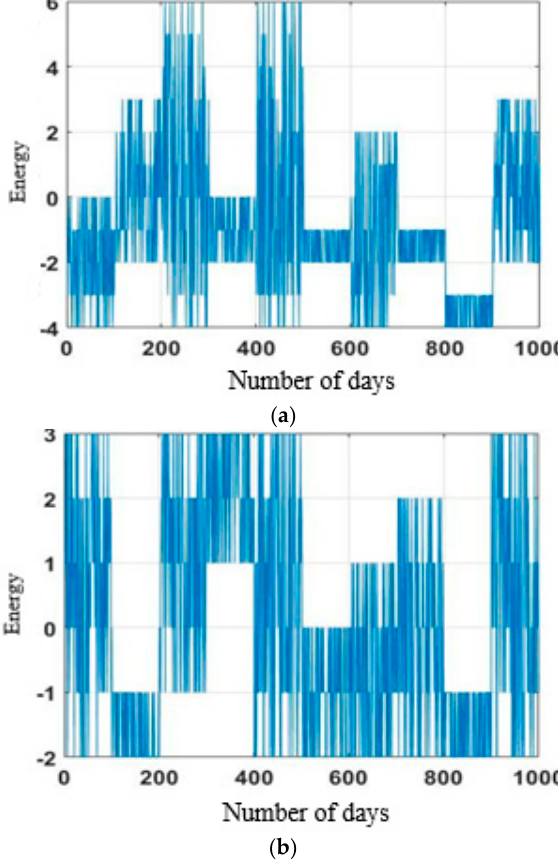
Figure 3. Refined data samples of ( a ) the AEP dataset and ( b ) the IHEPC dataset.